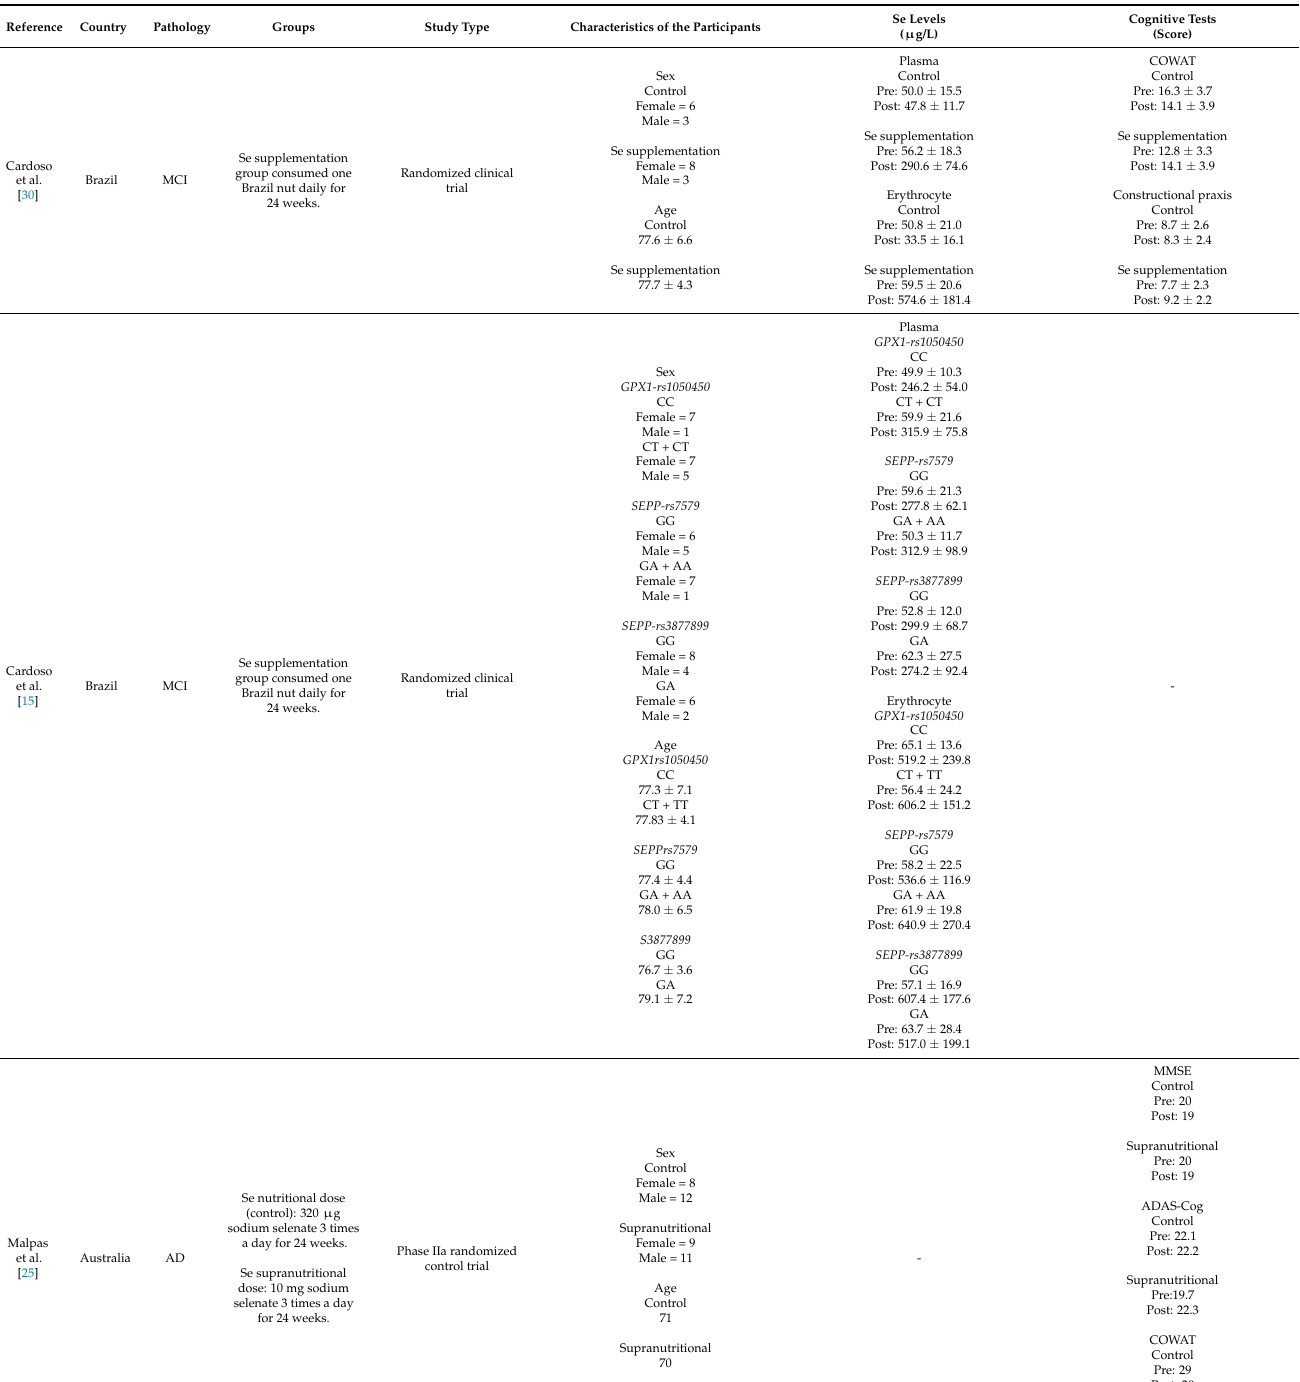
Table 1. Summary of systematically selected papers (only Se